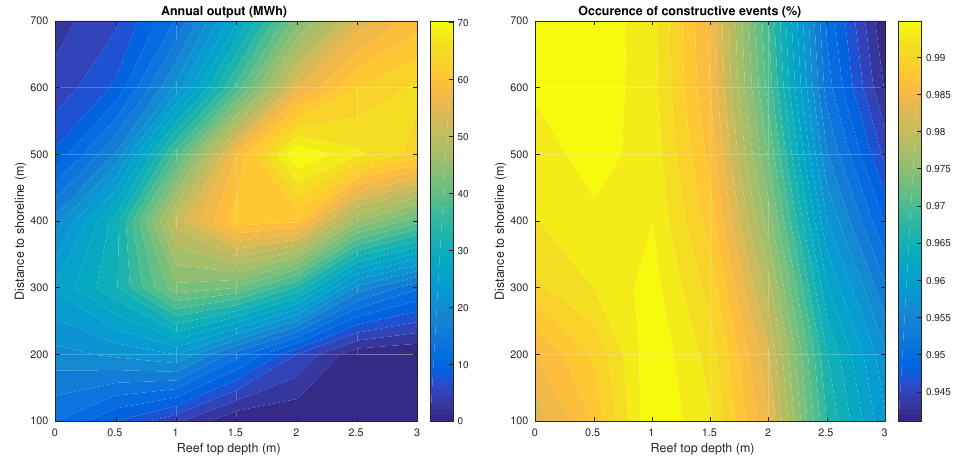
Figure 7. ( Left ) Annual energy production for a synthetic wave and tide climate versus reef top depth and distance to the shoreline. ( Right ) Annual occurrence of constructive conditions versus reef top depth and distance to the